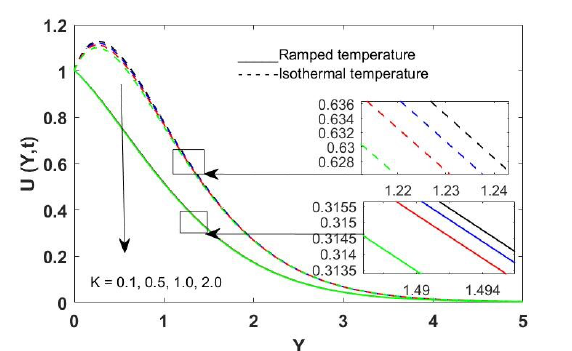
Figure 12: Momentum distribution versus K t =0.3, R=0.2, Q=0.2, S=1, kp=1.5, E=1, Ω = 30 0 , ψ = 0.5 , Pr =0.71, Sc =0.60, Gr=3, Gc=4